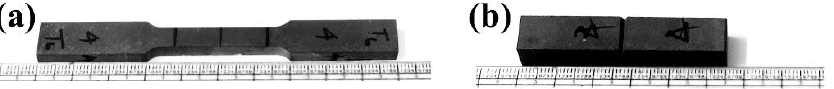
Figure 1. ASTM standard specimens for ( a ) Tensile test — ASTM E08; ( b ) Impact test — ASTM E23 .